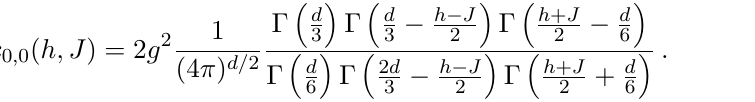
two-point function (3.5) and four-point function (3.9), obtained from the 2PI effective action, provide an example of the situation imagined in Hypothesis